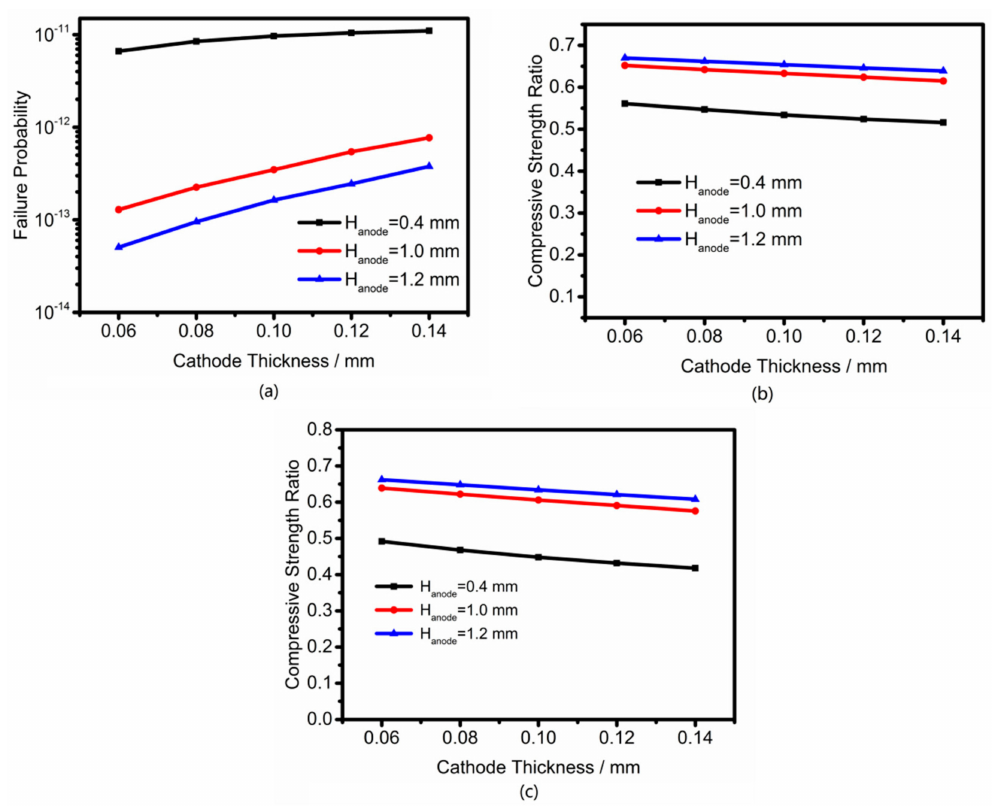
Figure 6. Effects of the cathode layer thickness on ( a ) the anode failure probability; ( b ) the compressive stress strength ratio of the electrolyte; ( c ) the compressive stress strength ratio of the cathode. Results corresponding to the three anode layer thicknesses of H anode = 0.4, 1.0, and 1.2 mm are shown in black, red, and blue,